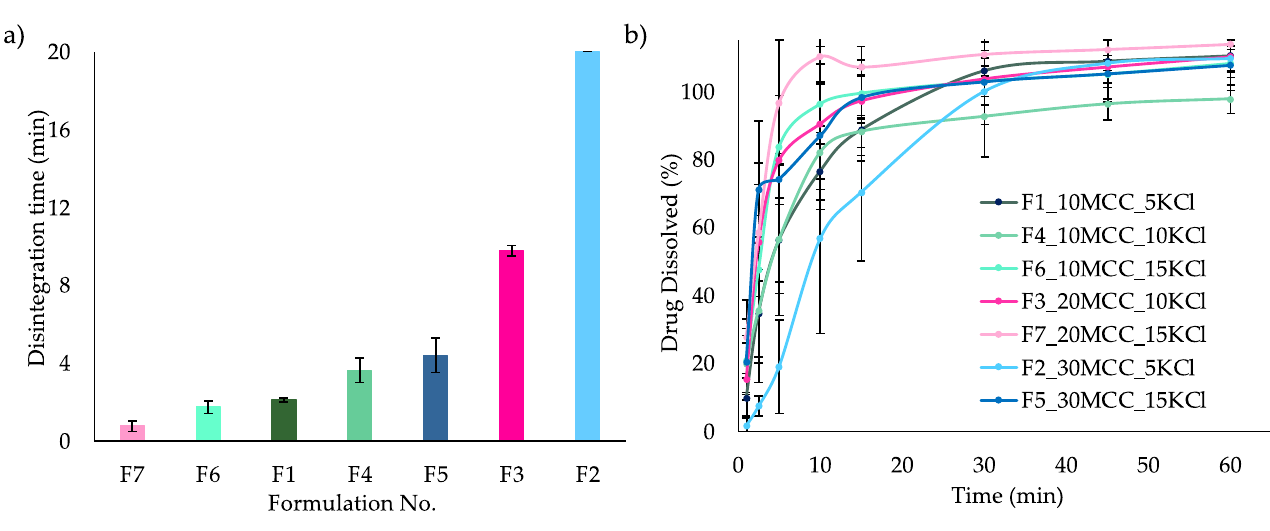
Figure 10. Disintegration ( n = 6) ( a ) and ( b ) dissolution plots ( n = 3) of ITZ-KOL-ASD round-tablet